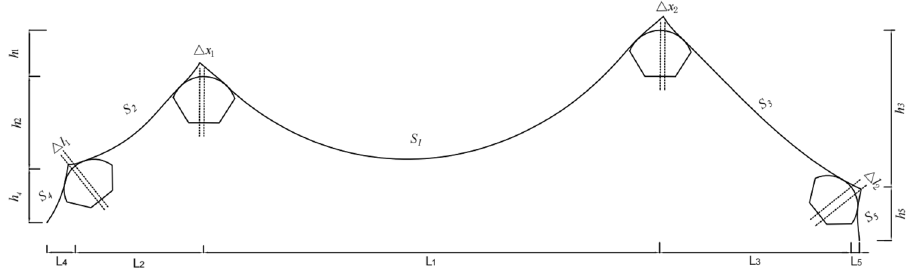
Figure 2. Schematic diagram of the overall calculation of the cable saddle pre-offsets.